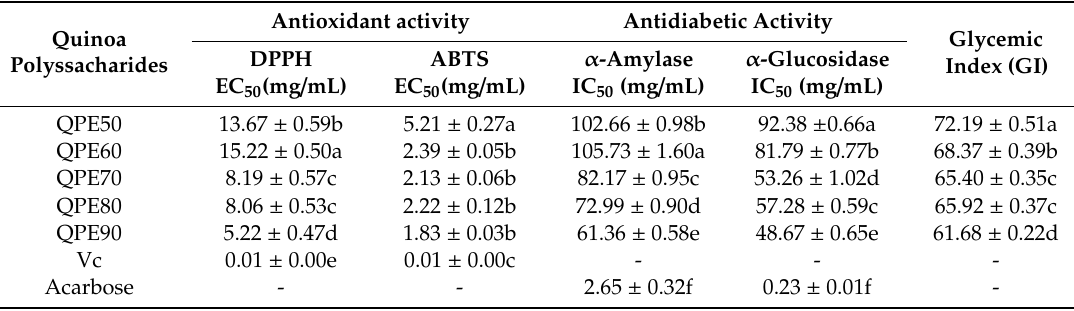
Table 3. Antioxidant, antidiabetic activities and glycemic index of